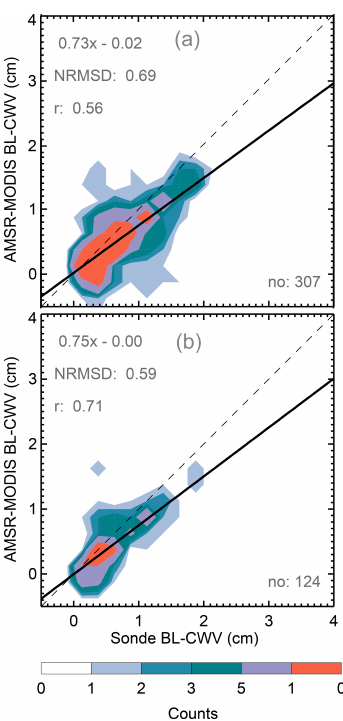
Figure 3. Sonde BL-CWV measurements scattered against the AMSR–MODIS BL-CWV estimates using ± 10km and ± 6h (a) and ± 1km and ± 6h (b) as coincidence criteria. The dashed black line is the one-to-one line. The solid black line displays a linear fit. The normalized root mean square deviation, the linear fit equation, the correlation coefficient R , and the total number of matches are